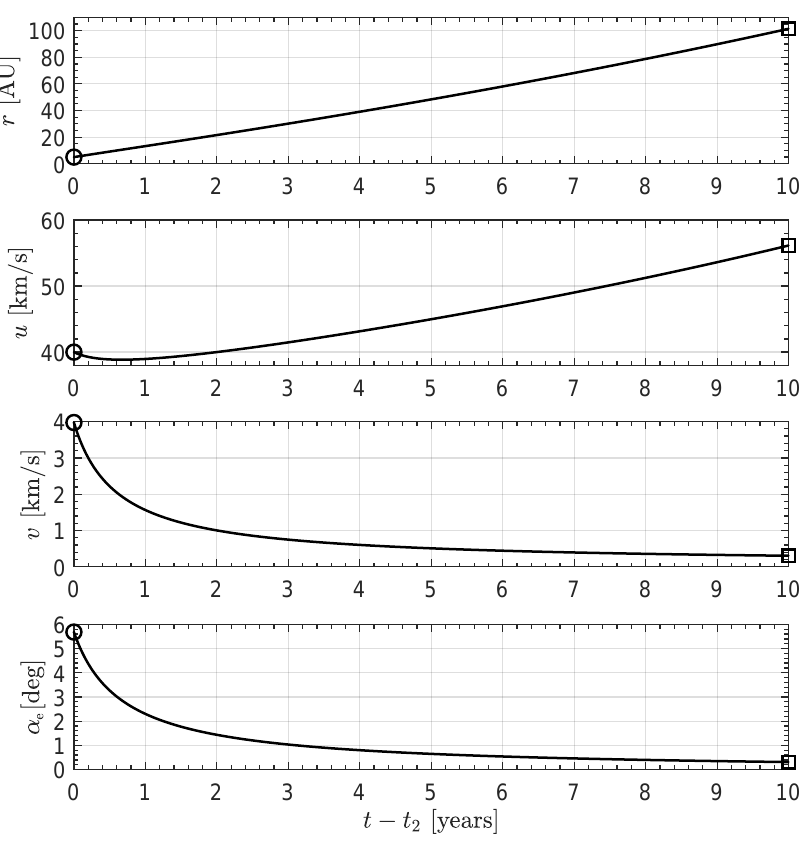
Figure 15. Heliocentric distance, velocity components and optimal steering law in phase